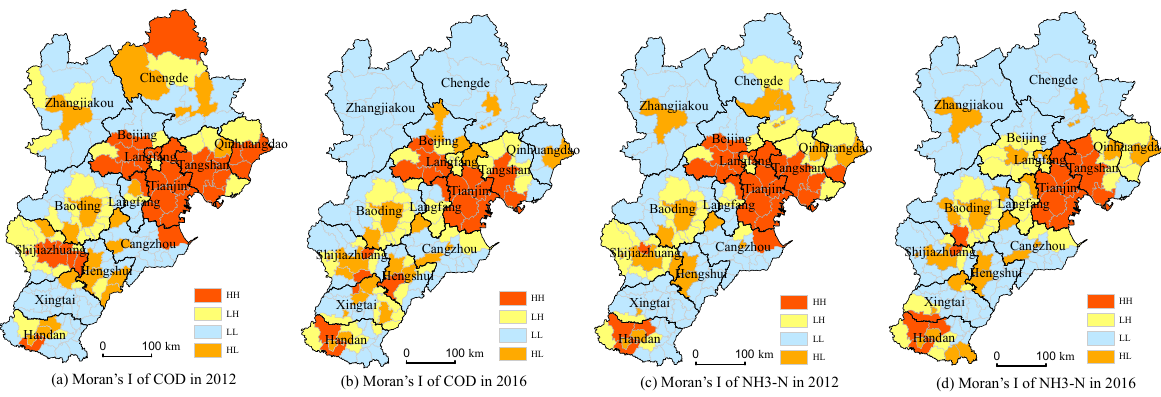
(d) Moran’s I of NH3-N in 2016(c) Moran’s I of NH3-N in 2012(b) Moran’s I of COD in 2016